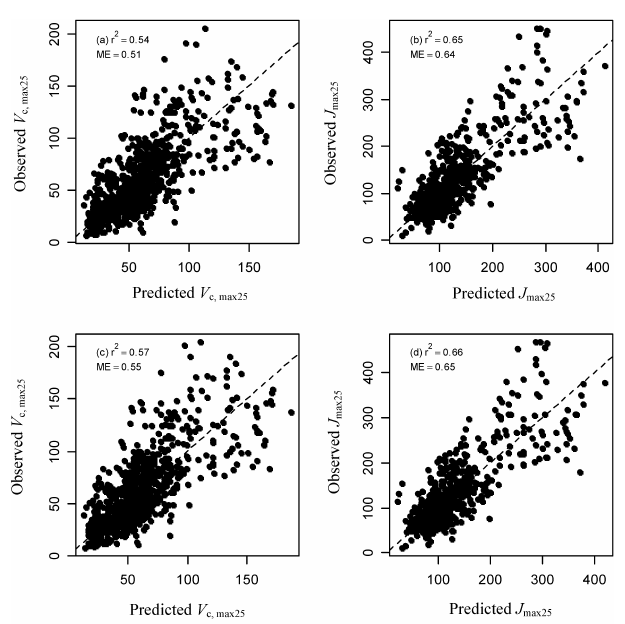
Figure 1. Percentage of variance ( r 2 and ME) in observed val- ues of V c , max25 (µmolCO 2 m − 2 s − 1 ) ( a , TRF1; c , TRF2) and J max25 (µmolelectronm − 2 s − 1 ) ( b , TRF1; d , TRF2) explained by the LUNA model for all the species. The r 2 is derived by a linear regression between observed and modeled values. The dashed line is the 1 : 1 line between observed and modeled